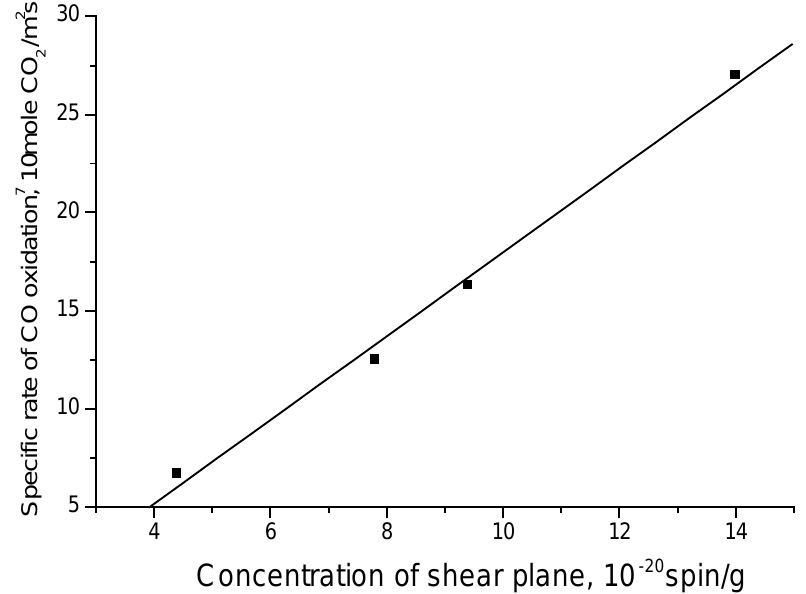
Fig.1 Dependence of the specific rate of CO oxidation vs. concentration of shear